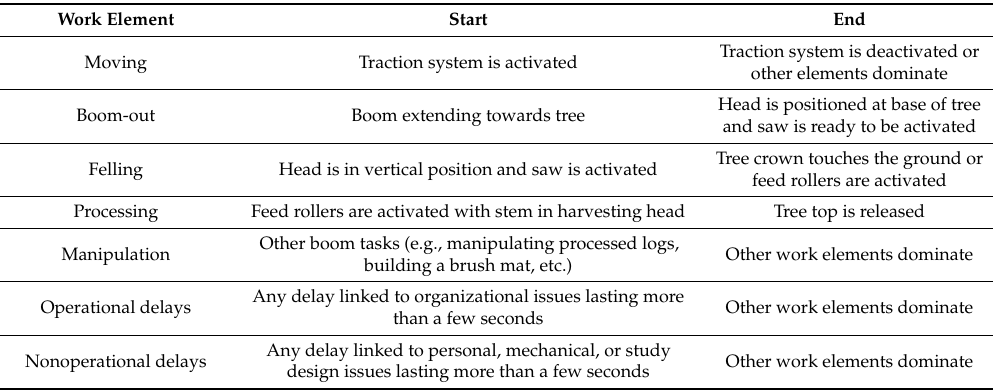
Table 2. Description of work cycle elements (from Labelle et al.